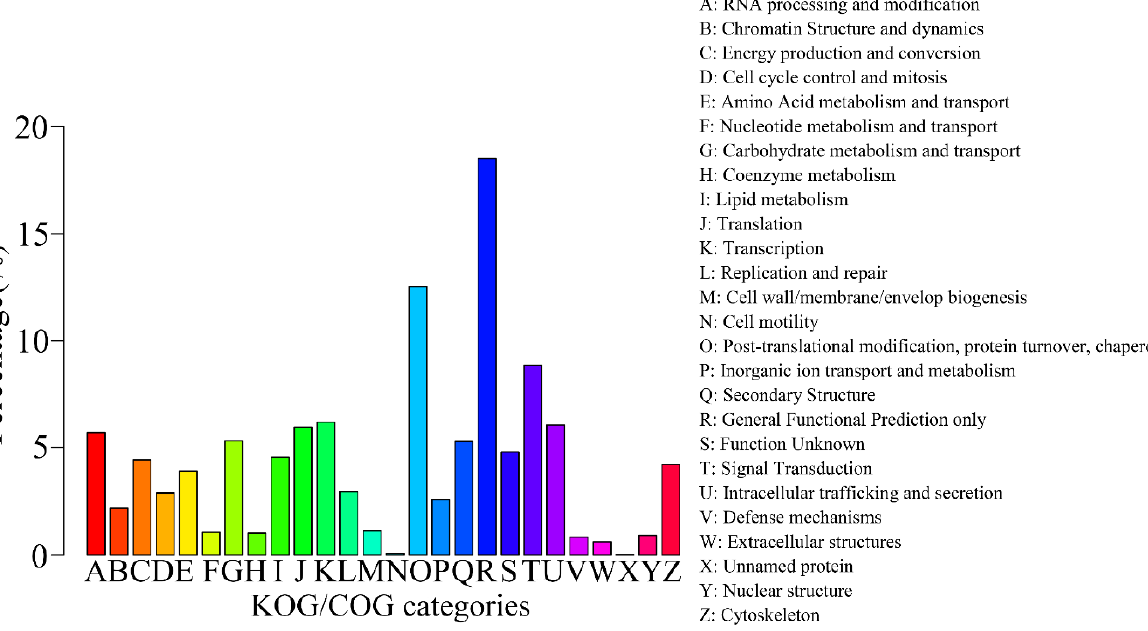
Figure 5. KOG/COG classification map. The abscissa represents 26 group names of KOG/COG, while the vertical axis represents the number of genes annotated into the group and its proportion of total number of annotated